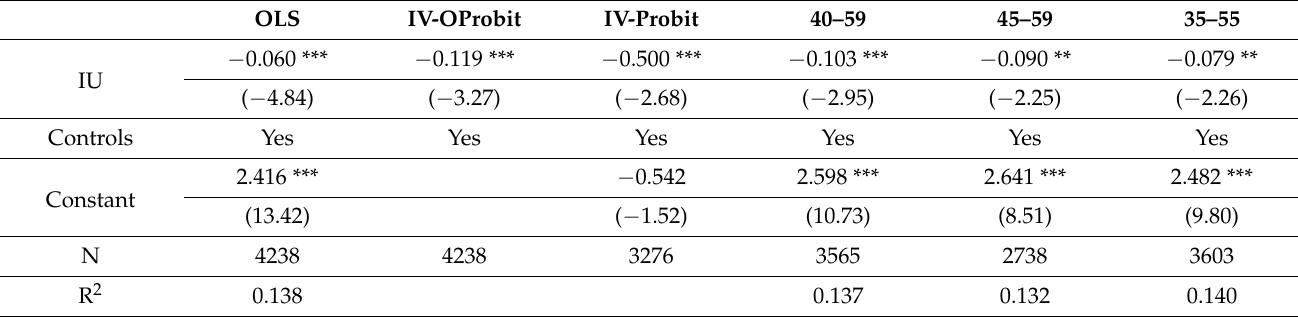
Table 4. Sensitivity analysis.